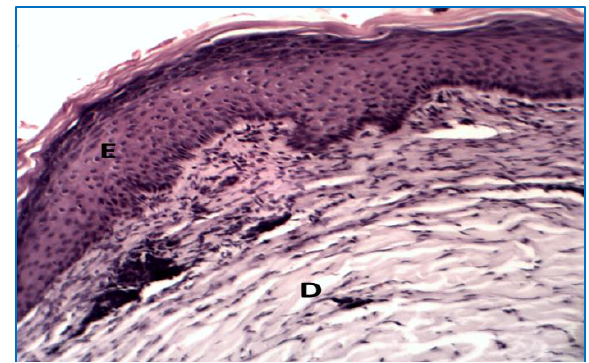
Figure, 12: Section of skin (14 days post treatment with amniotic membrane) shows epidermis (E) and dermis (D). H and E, 40 x.